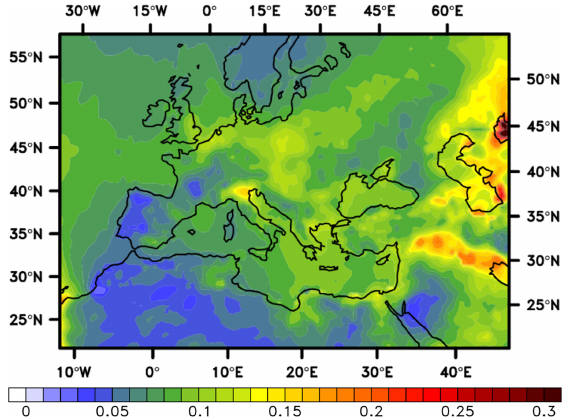
Figure 16. Average aerosol optical depth (AOD) contributed by particulate sulfate validated against AERONET AOD observations over the period 2003–2009. As mentioned at http://www.esrl.noaa. gov/gmd/grad/surfrad/aod/, a value of 0.01 corresponds to an ex- tremely clean atmosphere, and a value of 0.4 to a very hazy condi- tion (the 2003–2010 average AOD over the Mediterranean Basin is ∼ 0 . 20) (adapted from Nabat et al.,